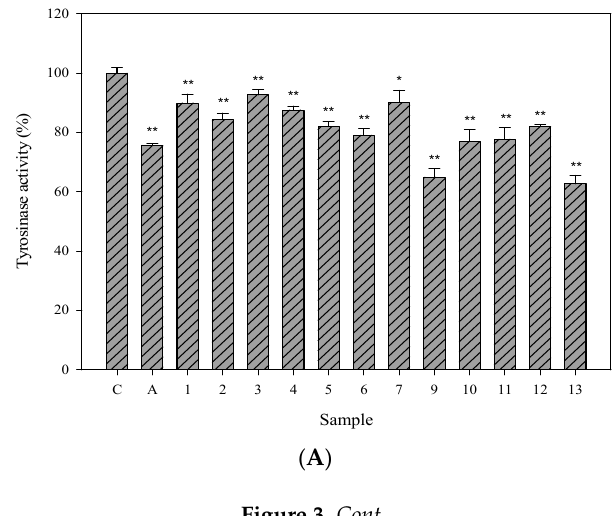
Figure 3. Cont. Figure 3.